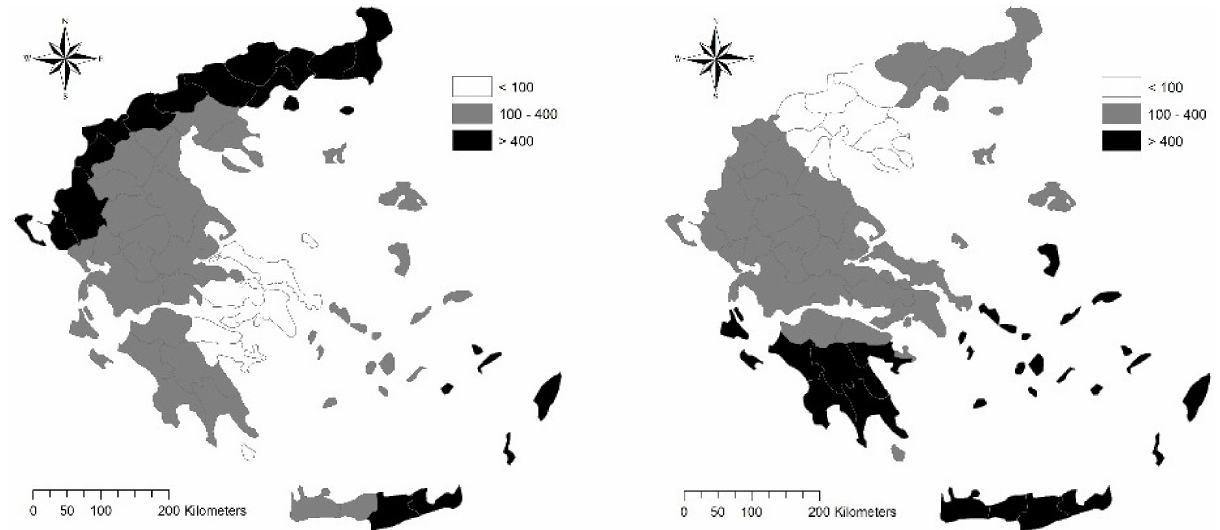
Figure 1. Map of Greek prefectures based on ELSTAT shapefiles, indicating the average distance (km) from Athens ( left ) and Thessaloniki ( right